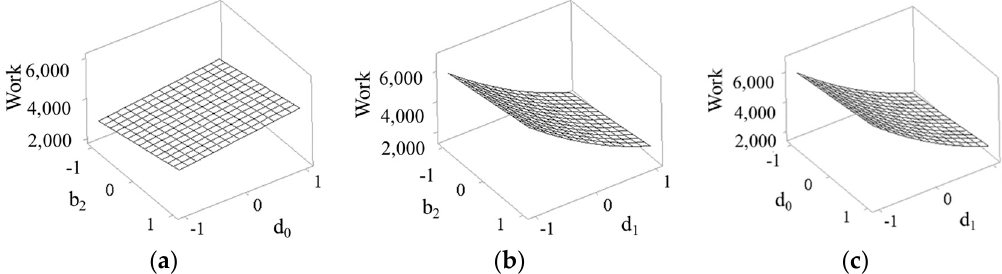
Figure 15. Response surface results of work. ( a ) Design variable b 2 , d 0 ; ( b ) Design variable b 2 , d 1 ; ( c ) Design variable d 0 , d 1 .